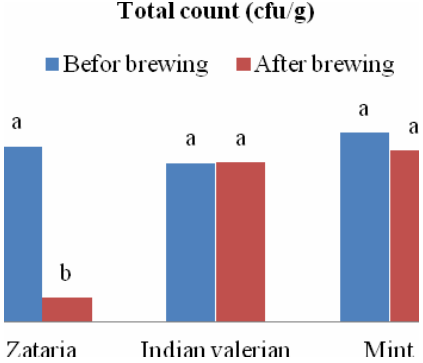
Fig. 4. Mean comparison of total count in brewing